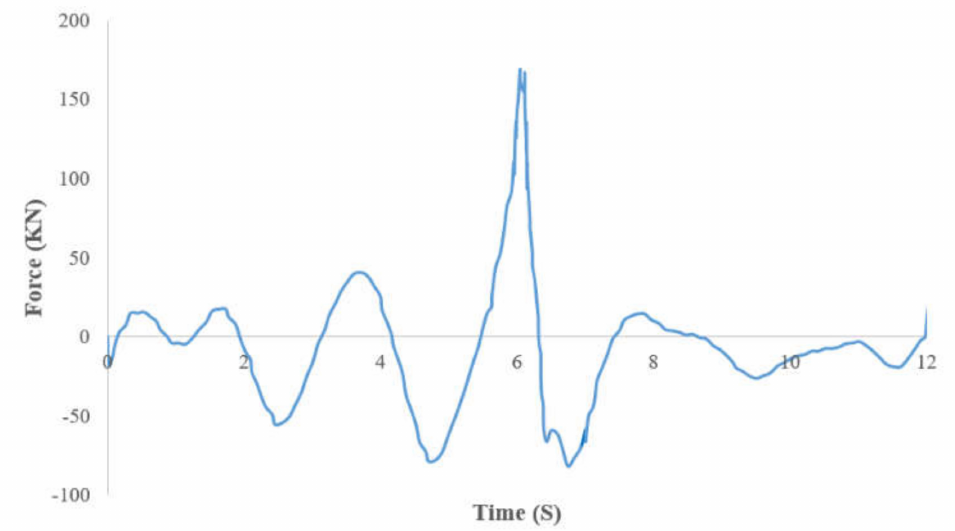
Figure 6. The force history used in this research as the sea waves clash to the middle steel piles